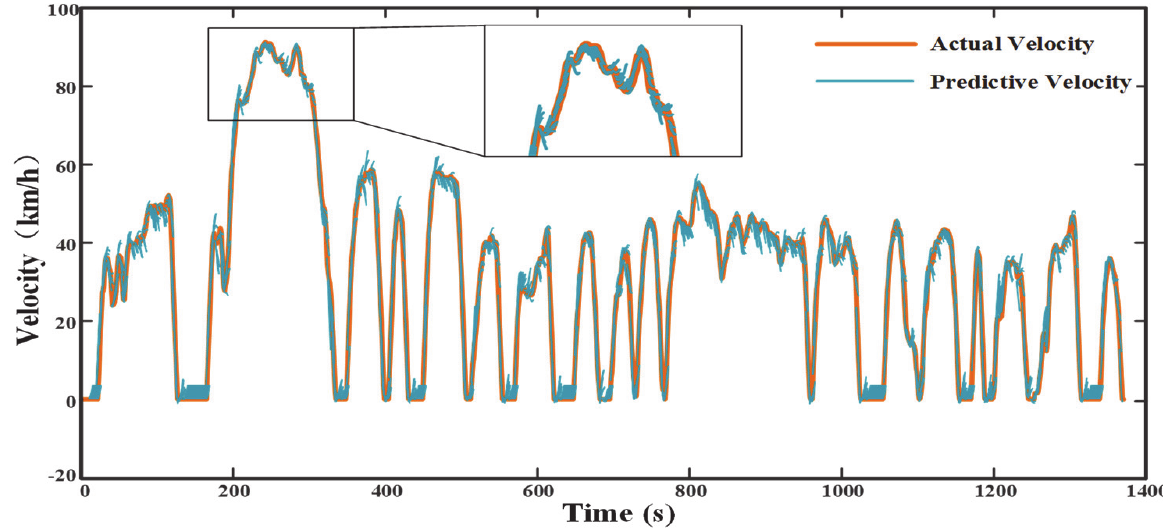
Figure 13. Prediction performance of PSO − BP neural network predictor at 5 s prediction step.